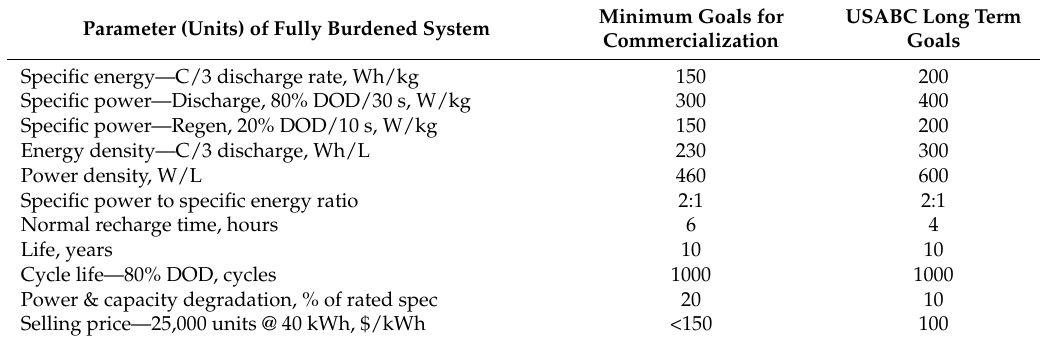
Table 3. USABC commercialization and long term performance goals for EV battery packs